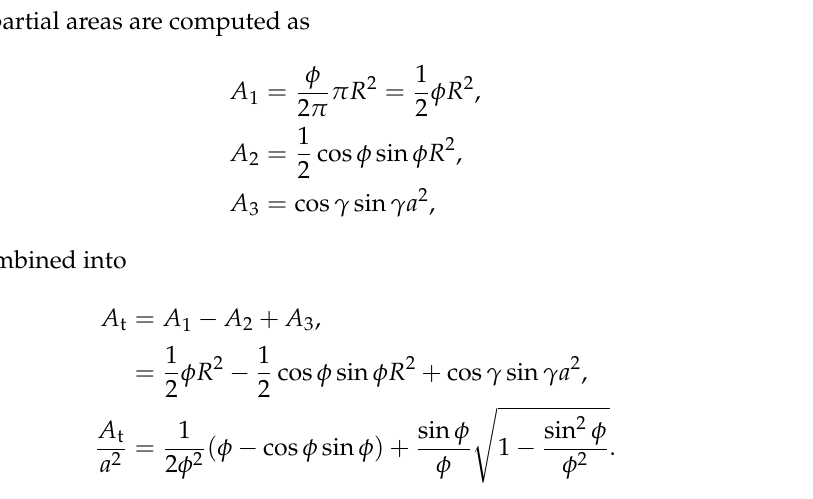
This relation between the angle φ and the non-dimensional total cross-sectional area A t / a 2 is plotted in Figure 8, together with the non-dimensional width of the quarter segment given by Equation